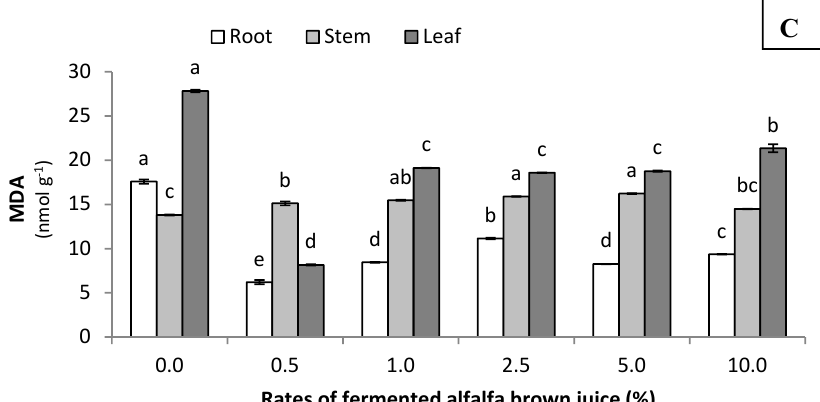
Figure 3. The activity of catalase ( A ) and peroxidase ( B ) and malondialdehyde content ( C ) in different plant tissues (roots, stems, and leaves) of Celosia plants sprayed at different rates of fermented alfalfa brown juice. Sample size ( n = 6). Different letters above the same columns show significant differences at the level of p < 0.05.